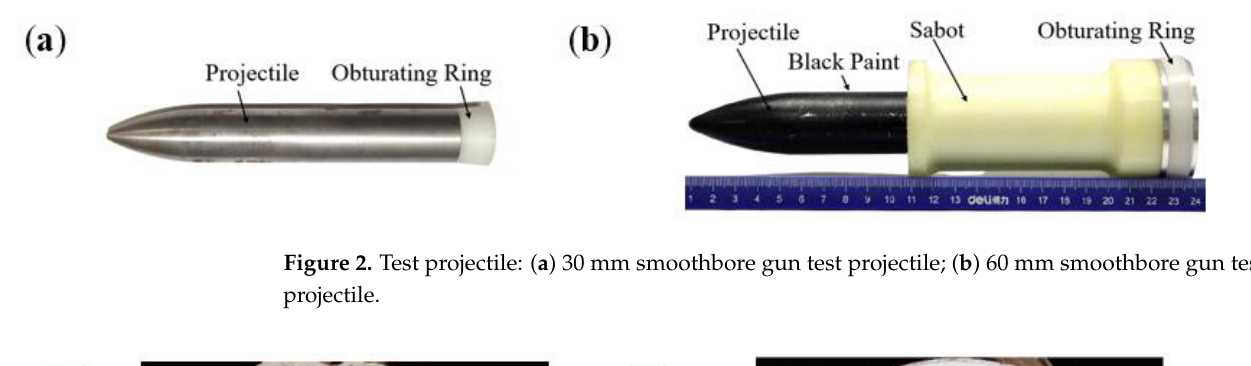
Figure 1. Test site layout: ( a ) 30 mm-diameter smoothbore gun; ( b ) 60 mm-diameter smoothbore gun.